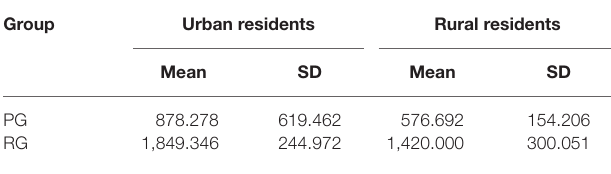
TABLE 1 | Descriptive statistics for the per capita income of groups.